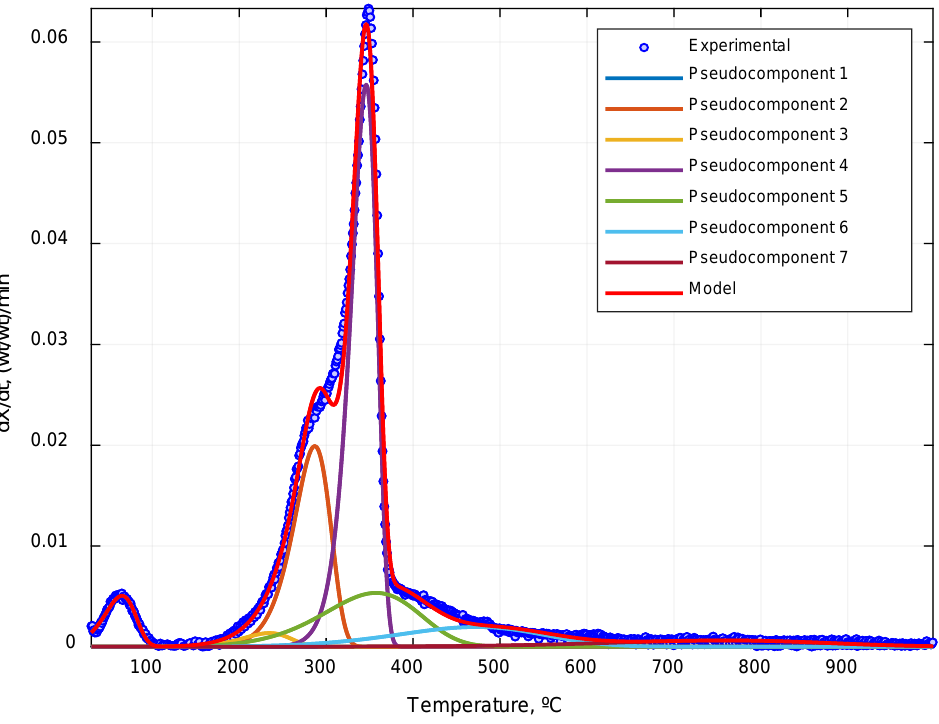
Figure 6. Model fitted to the experimental willow DTG curve. Processes 2020 , 8 , x FOR PEER REVIEW